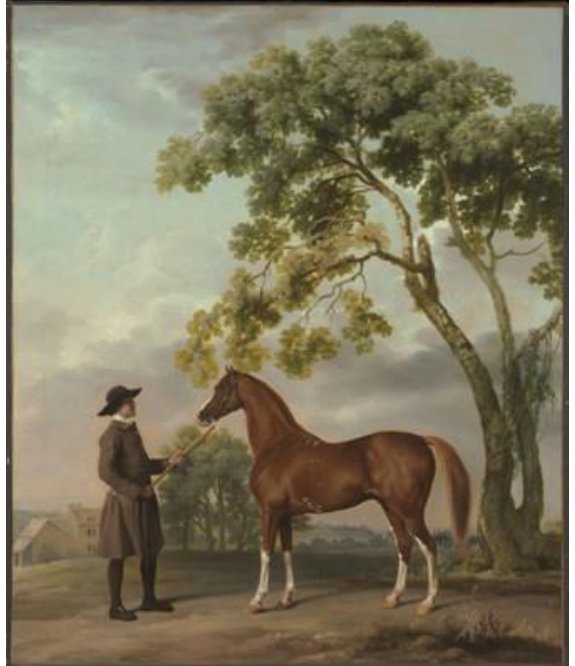
Figure 18. George Stubbs, British (1724–1806). Lord Grosvenor’s Arabian Stallion with a Groom, c. 1765. Oil on canvas. 99.3 × 83.5 cm. Kimbell Art Museum, Fort